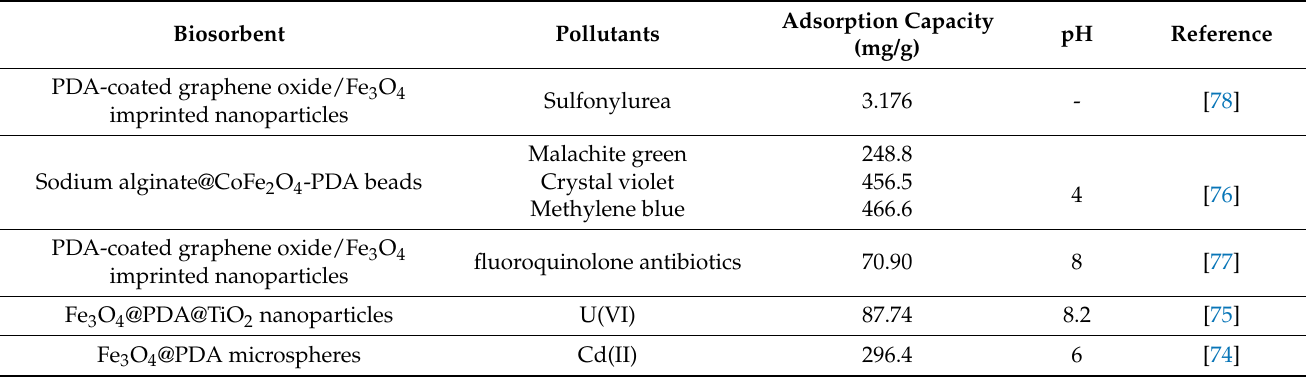
Table 1. Fe 3 O 4 @PDA nanocomposites for the uptake of organic and inorganic